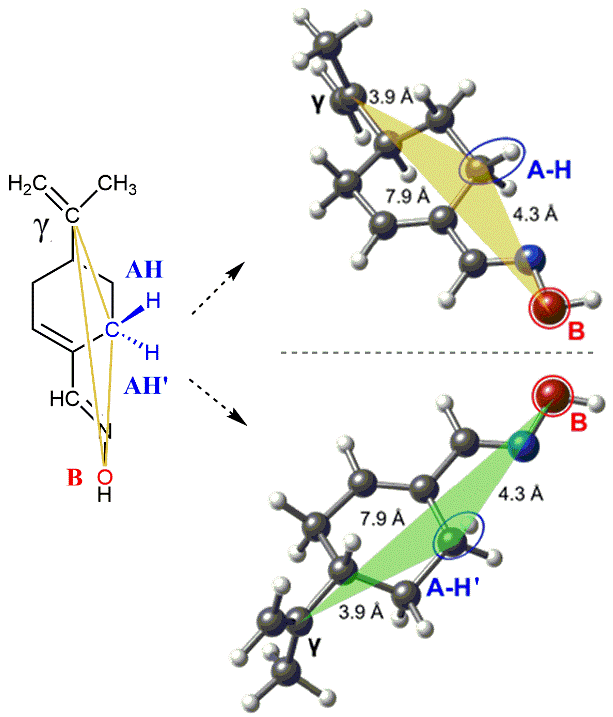
Figure 4. The most stable structure of perillartine highlighting the most favorable “sweetness triangle”, which could be established in both “top” and “bottom” faces of the molecule. The distances are given in Angstroms.